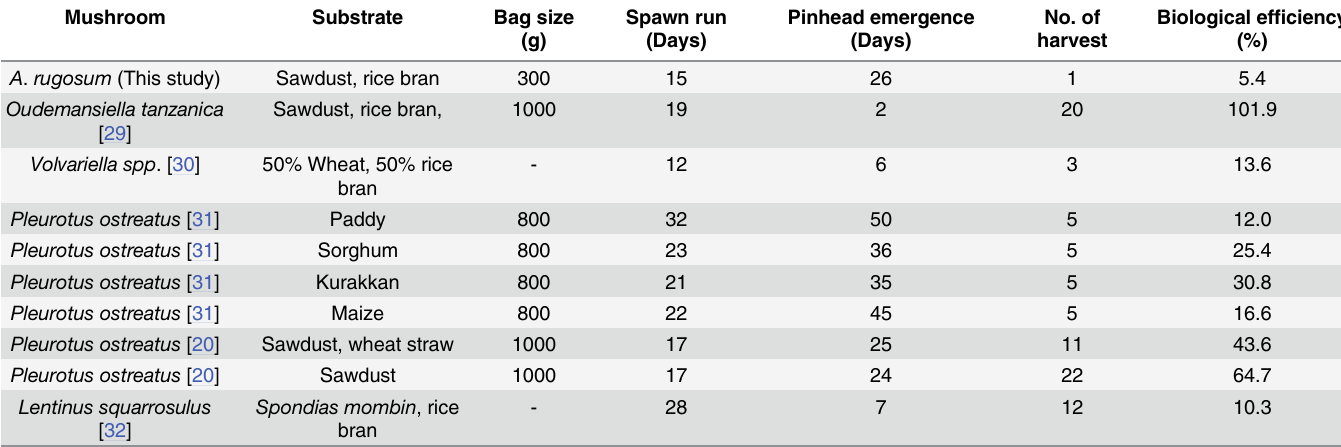
Table 4. Comparison of spawn run and yield of selected domesticated or cultivated mushrooms.